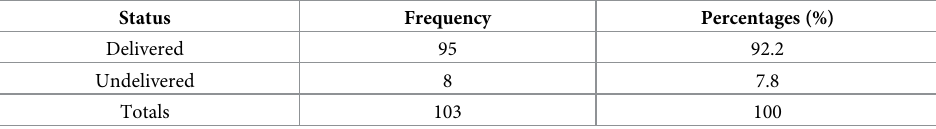
Table 4. Text messages sent to